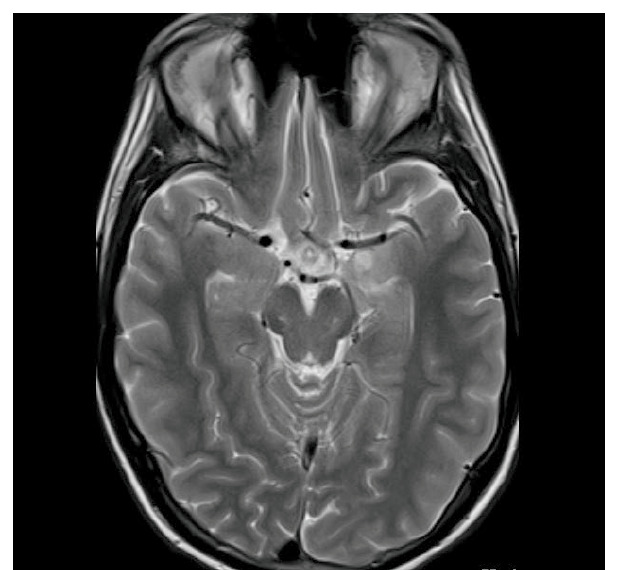
Fig. 3. Axial T2-weighted MR image at the level of the temporal lobes. Fig. 4. Coronal post-gadolinium T1-weighted MR image at the level of the temporal lobes.